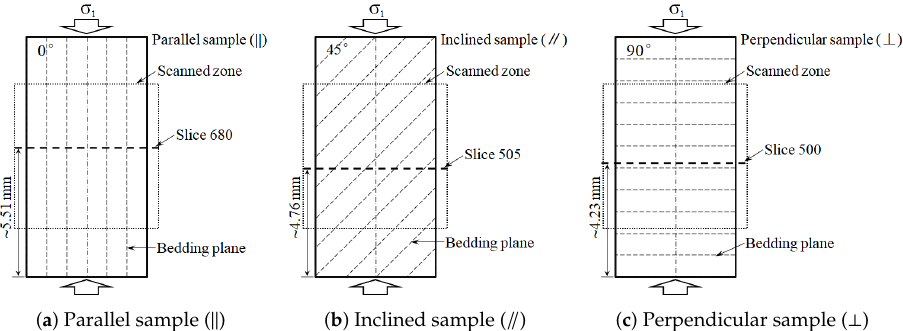
Figure 9. Positions of the selected slices in the three samples ( (cid:107) , ∥ , and ⊥